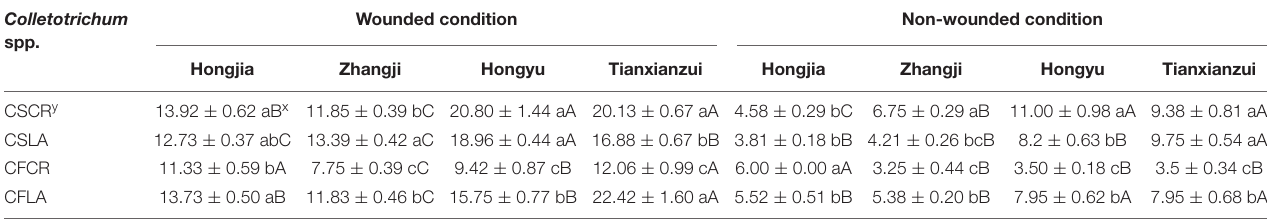
x Data are mean ± standard error. Mean values with the same letters were not statistically different (P > 0.05) according to the least significant difference (LSD) test. y CSCR, C. siamense causing crown rot; CSLA, C. siamense causing leaf anthracnose; CFCR, C. fructicola causing crown rot; CFLA, C. fructicola causing leaf